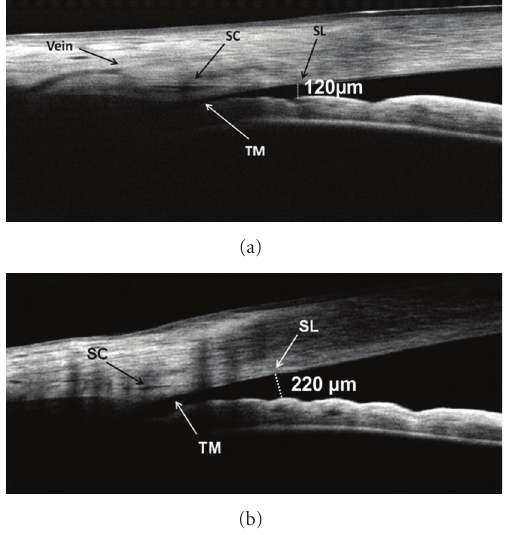
Figure 2: Frame-averaged cross-sectional OCT image of the nasal angle in a normal subject. The high resolution helps to visualize the termination of the endothelium and Descemet’s membrane (Schwalbe’s line, SL), which is a useful landmark on these images. Also visible are the external limbus (EL), Schlemm’s canal (SC), and the trabecular meshwork (TM). The scleral spur (SS) is faintly visible in this case. The angle recess, iris root, and ciliary body are not visible due to blocking by the sclera. The angle opening distance between SL and the anterior surface of the iris (AOD-SL, dotted line) was 361 µ m, indicating that the angle is open.